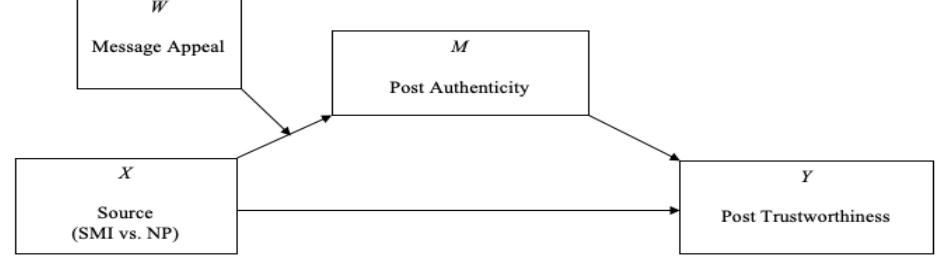
Figure 1. Illustration of PROCESS Model 7—Moderated Mediation Model (with hypothesised analysis). SMI, social media influencer; NP, nutrition professional. Letters ( M , W , X , Y ) are variables not abbreviations.